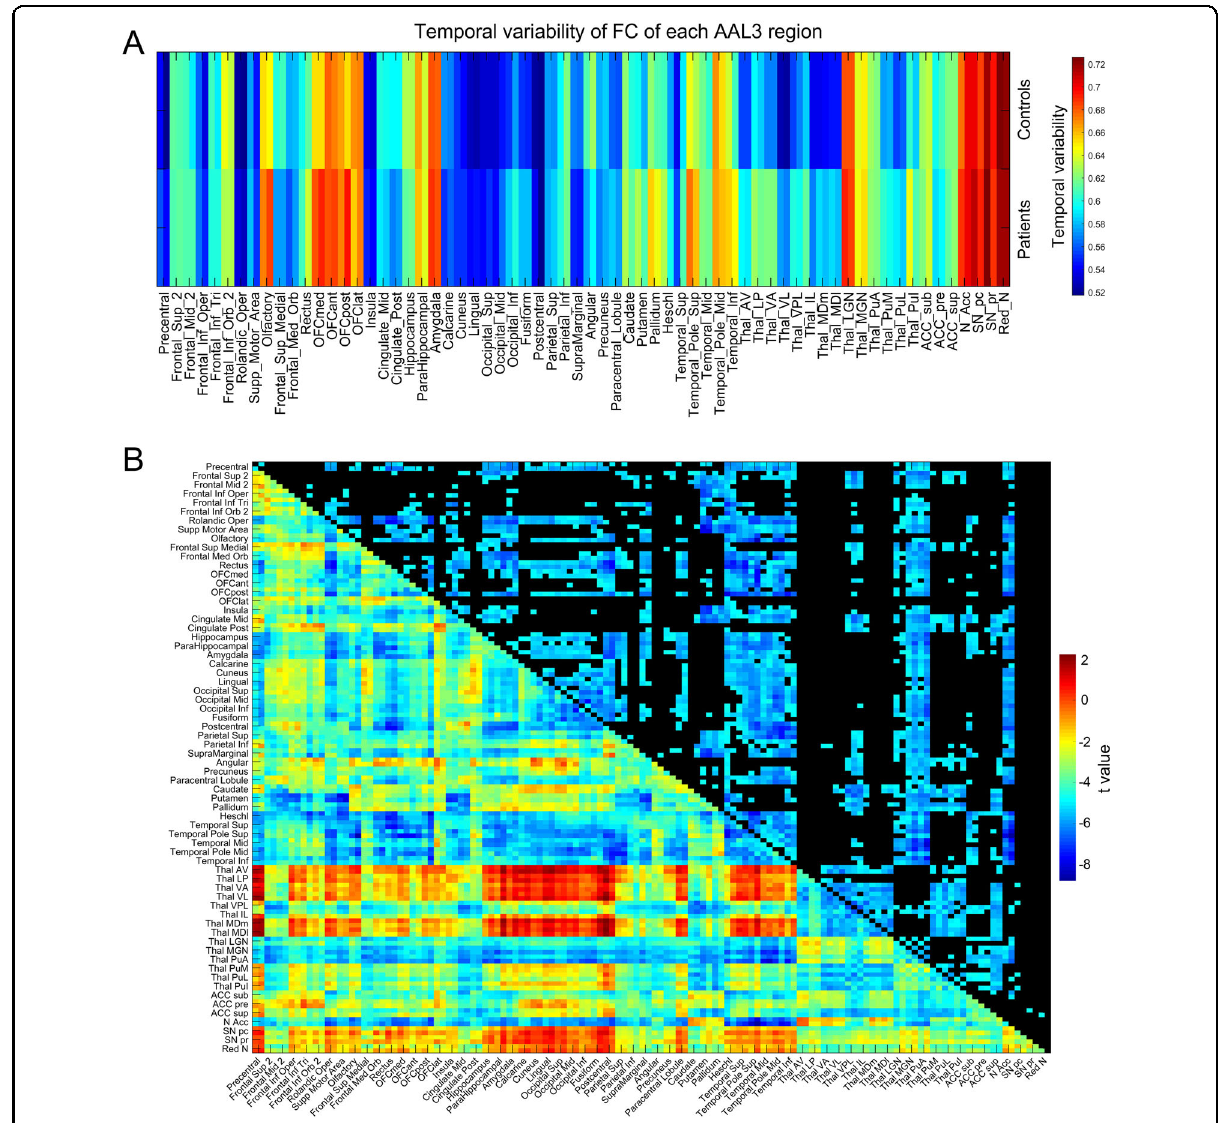
Fig. 2 Higher temporal variability of functional connectivity of some brain regions in chronic schizophrenia. A The temporal variability of the functional connectivity of different AAL3 regions in the chronic schizophrenic and control groups. B The functional connectivity of AAL3 areas for the chronic schizophrenic group minus controls. The lower left shows the t -value for the difference in functional connectivity of patients - controls; the upper right shows the signi fi cantly different functional connectivities after Bonferroni